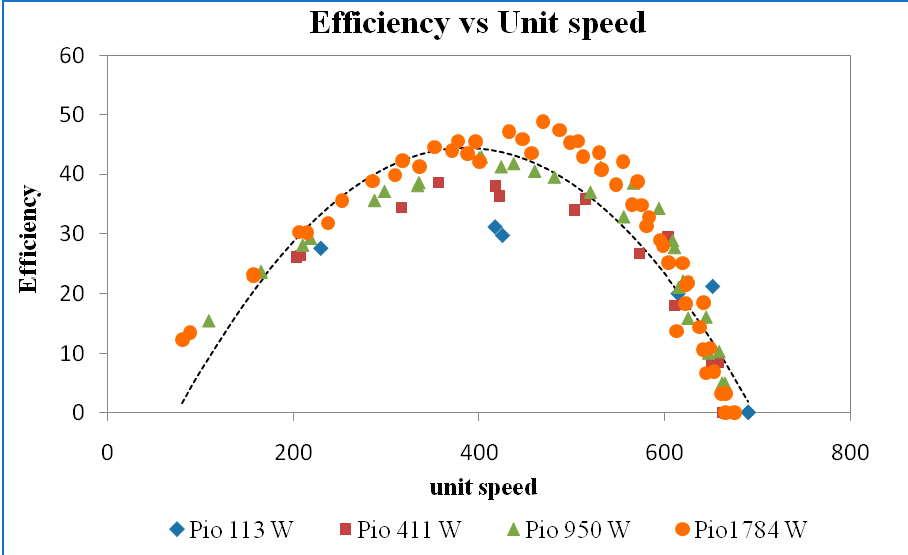
Figure 33. Efficiency vs. unit speed at a guide vane opening of 16 mm. The unit discharge versus unit speed curve is shown in Figure 34. The unit discharge decreases with increasing unit speed. The unit discharge curve looks similar to GVO of 13 mm, 16 mm, and 19